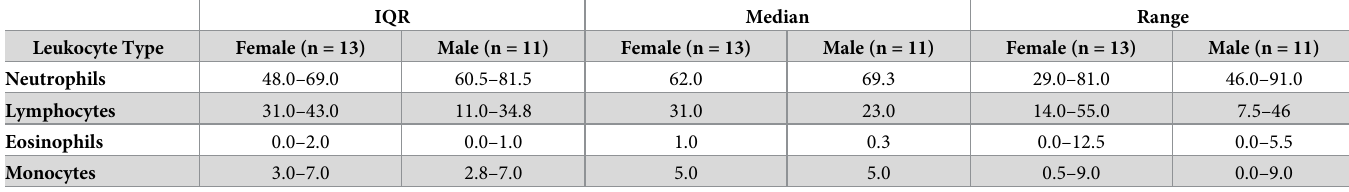
Table 2. Leukocyte profiles of P . alecto with observed mild/minor injuries. IQR